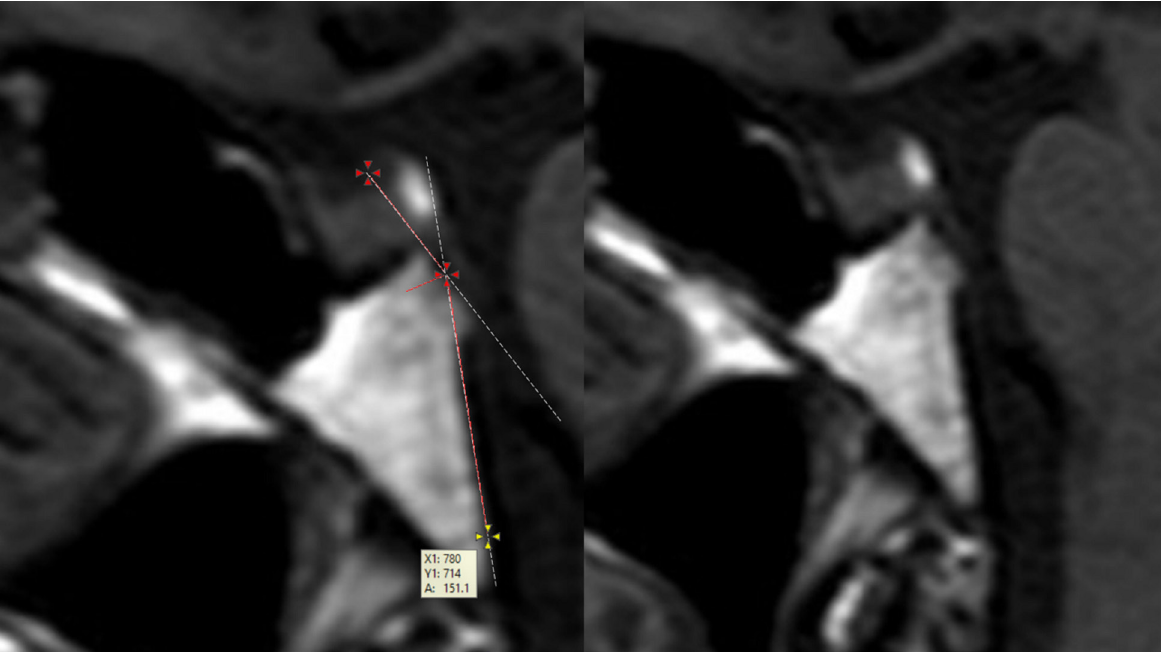
Figure 4. Image showing a flexed Spheno-occipital synchondrosis angle. At left angular measurement. At right side, original image for detailed anatomical